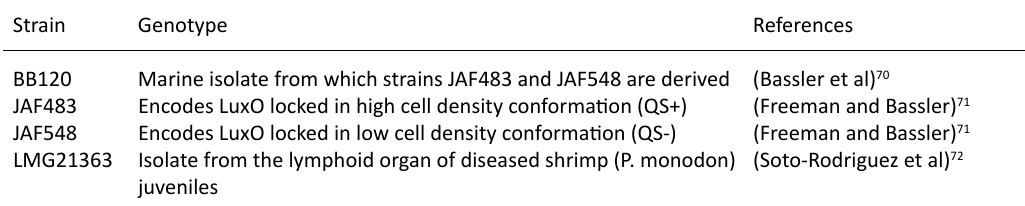
table 2. Concentration of S. marinoi and V. harveyi used in this experiment Treatment